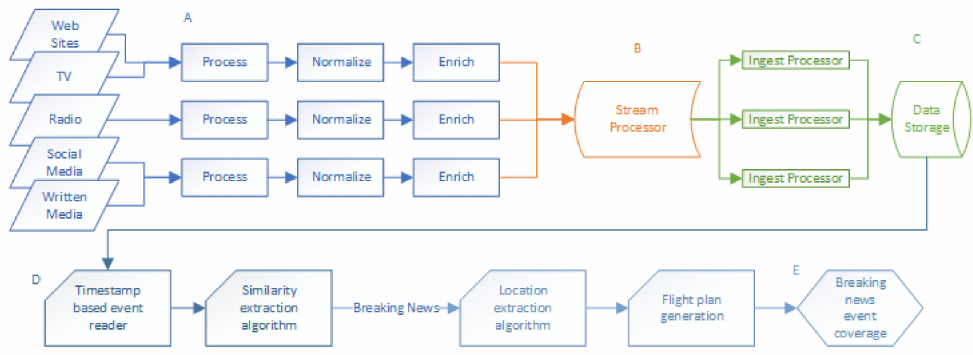
Figure 2. Block diagram of the implemented data